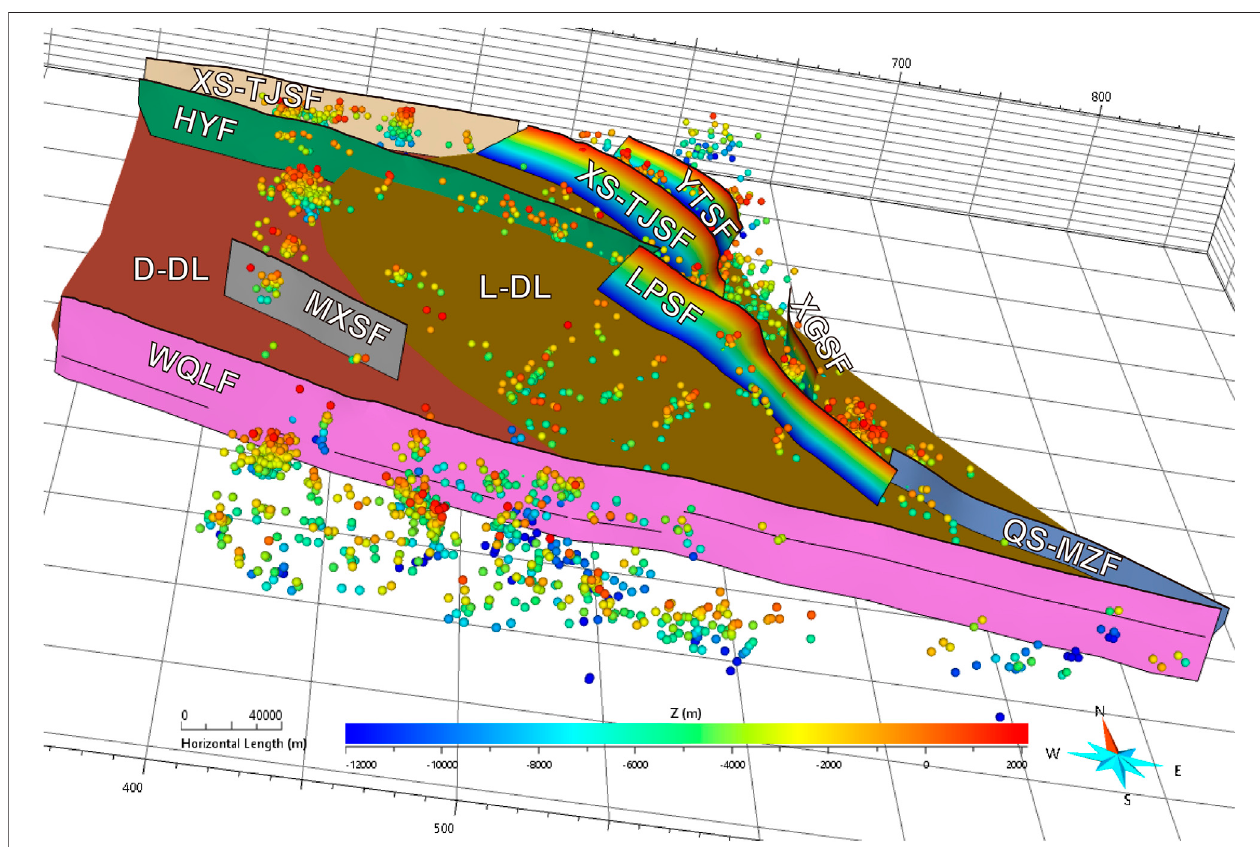
FIGURE6| Sideviewof3DfaultmodelV2oftheactivefaultsinthearc-shapedtectonicbeltinthenortheasternmarginoftheTibetanPlateau.Thedifferentcolored spheres represent the accurate locations of small earthquakes at different depths (The spheres in Figure 7 and Figure 13 have the same meaning). L-DL, detachment layer of 12 km deep; D-DL, detachment layer of 22 km deep (The abbreviations in Figure 7 and Figure 12 have the same meaning).